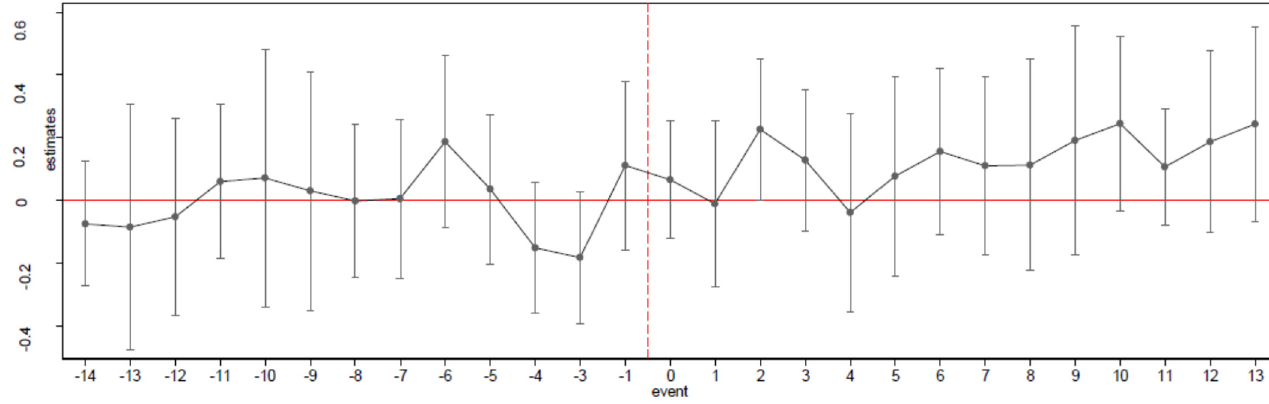
Figure 10. Parallel Trends Analysis—Event Studies on Loans Granted—Transport Sector. Funding: T his research received no external funding. Institutional Review Board Statement: Not applicable. Informed Consent Statement: Not applicable. Data Availability Statement: Restrictions apply to the availability of these data. Data was obtained from Banco Estado Microempresas and are available from the corresponding author with the per- mission of Banco Estado Microempresas.